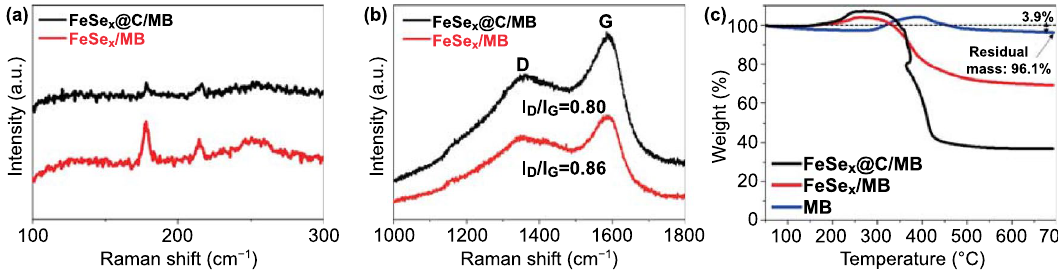
Fig. 4 a, b Raman spectra of FeSe x @C/MB and FeSe x /MB and c TG curves of FeSe x @C/MB, FeSe x /MB, and